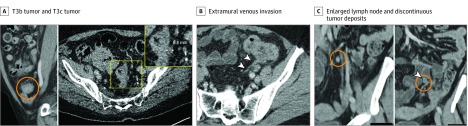
T Stage, N Stage, and Extramural Venous Invasion on Computed TomographyA, T3b tumor (within circle) shows 1- to 5-mm extramural spread; T3c tumor (inset) shows >5- to 15-mm extramural spread. B, Extramural venous invasion (arrowheads) from a tumor along the length of a vein. C, Enlarged lymph node (circle in left image) vs discontinuous tumor deposits (circle and arrowhead in right image) along the course of a vein.